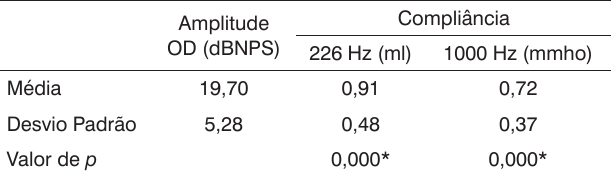
Tabela 3. Comparação entre amplitude da EOAT e a compli- ância em 226 Hz e 1000 Hz na